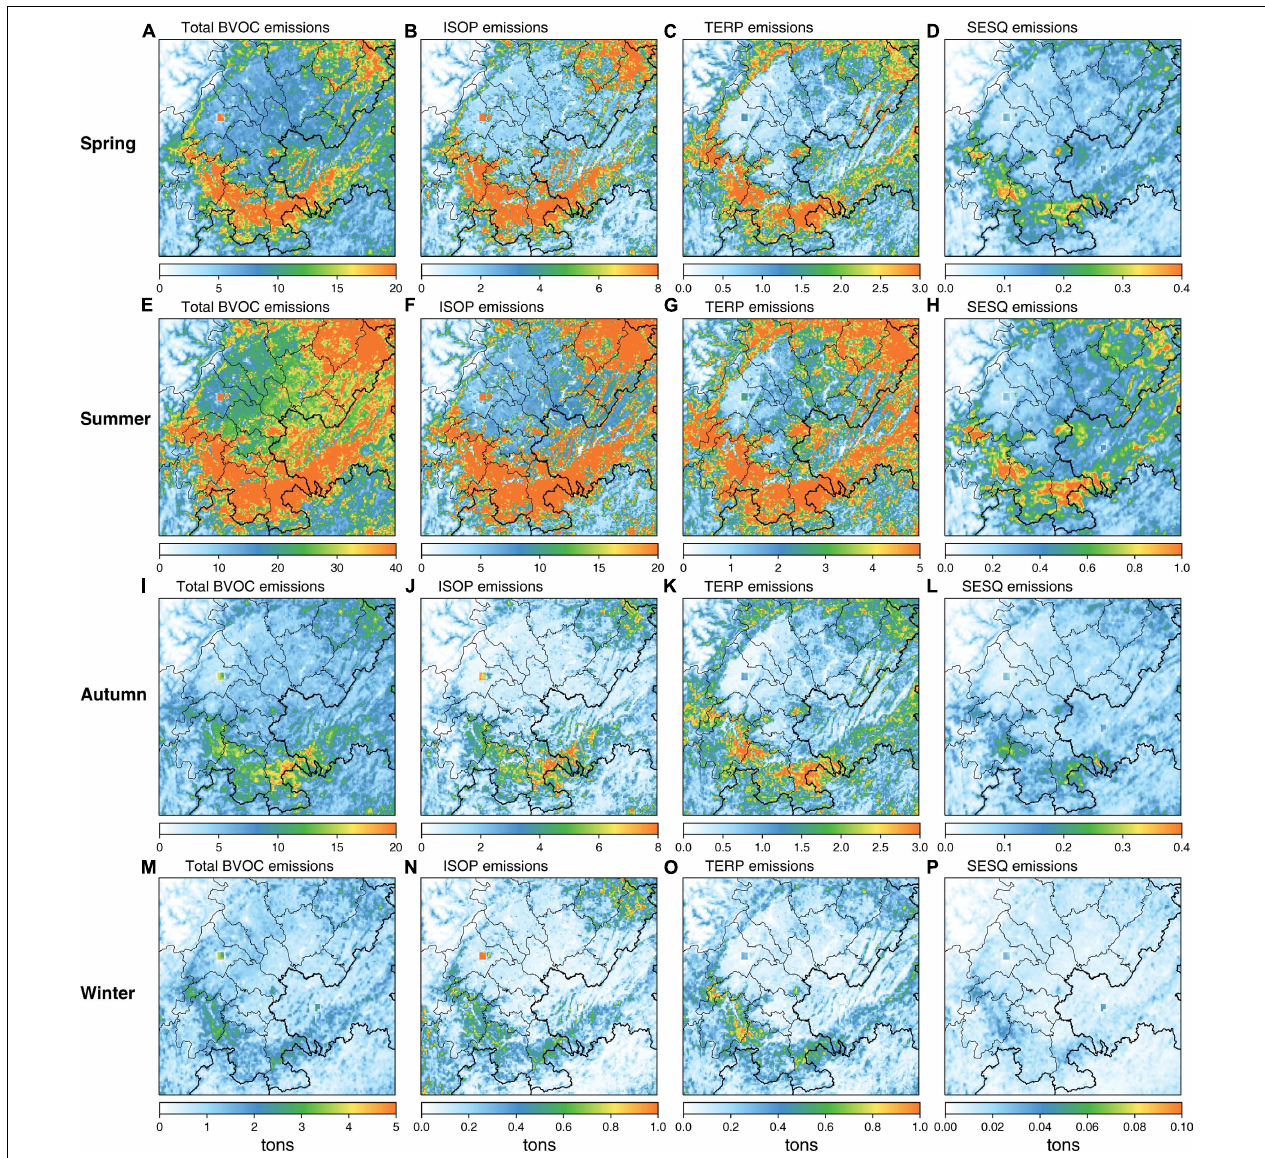
FIGURE 5 | Seasonal emissions of total BVOC, isoprene (ISOP), monoterpenes (TERP), and sesquiterpenes (SESQ) over the SCB in 2017 estimated by